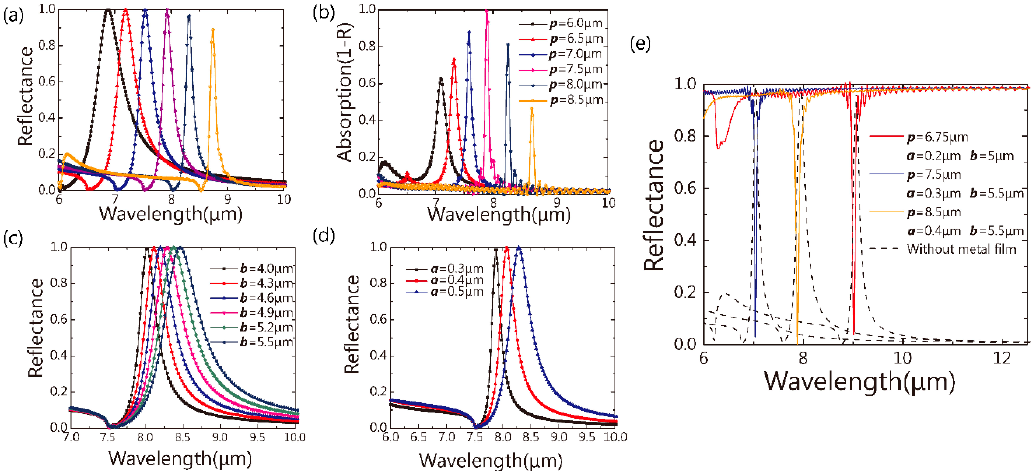
Figure 4. ( a ) The reflectance of the pure dielectric metasurface and ( b ) absorption of the hybrid metasurface (geometric parameters: a = 0.3 μ m, b = 5.5 μ m), while p varies from 6.0 μ m to 8.5 μ m; the reflectance spectra ( c ) of the pure dielectric metasurface ( a = 0.5 μ m, p = 7.5 μ m), while b varies